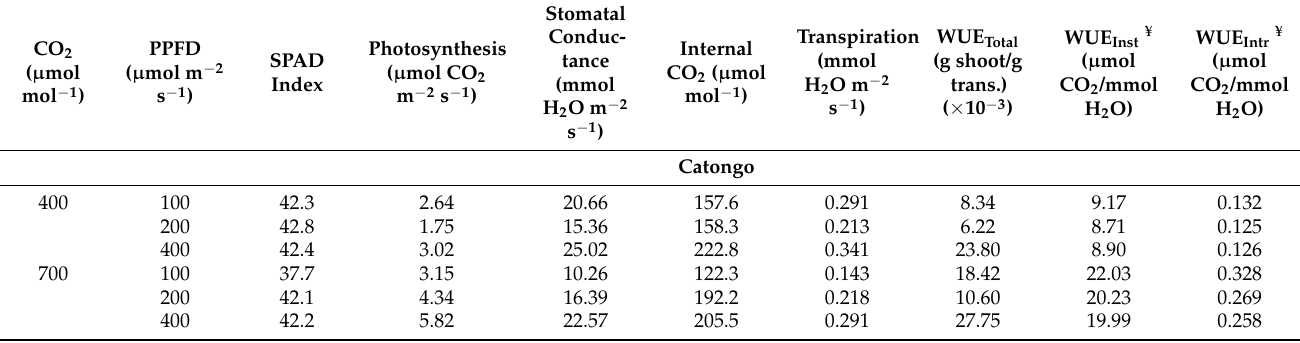
Table 2. The effect of [CO 2 ] and photosynthetic photon flux density (PPFD) on photosynthesis and its components, and water use efficiency of seven cacao